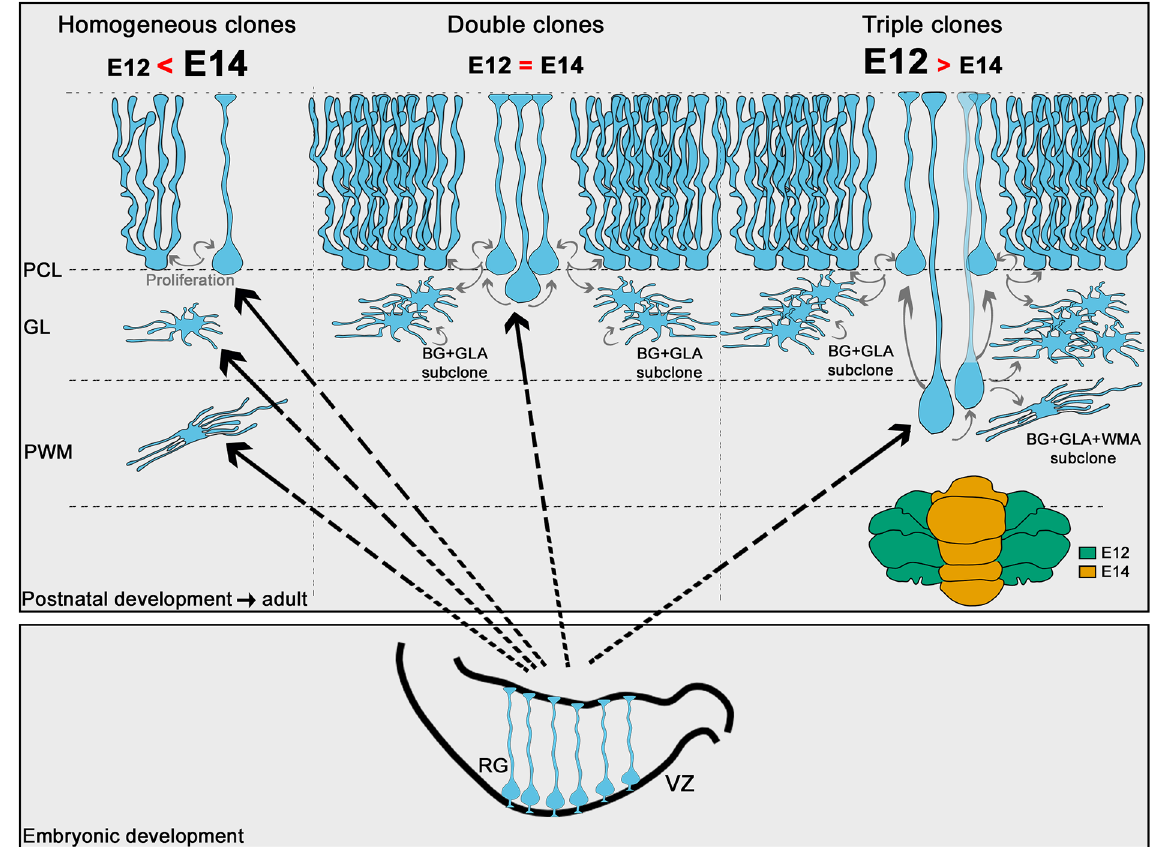
Fig 10. Schematic model for emergence of cerebellar astroglial lineages. Cerebellar astrogliogenesis occurs from RG that either generate HomCs for each major astrocyte type—more frequent among vermian E14-P30 clones—or HetCs. HetCs, including double and triple clones, are proposed to originate from intermediate basal progenitors derived from RG. Double clones are similarly produced by either E12 or E14 RG and appear composed on average of 2 subclones with the same modularity. In these subclones, BG dominates over GLAs, likely as the result of the amplification of ventricular progenitors translocated into the PCL. Triple clones, more frequent among E12-P30 lineages, include the 3 major astrocyte types and appear composed by 3 subclones belonging to distinct typologies, depending on the presence of WMAs. Subclones can be formed by BG+GLA types, in which case they show modularity, and by BG+GLA+WMA types, in which case there is no apparent modularity but a very diverse cell type composition. BG, Bergmann glia; E, embryonic day; GL, granular layer; GLA, granular layer astrocyte; HetC, heterogeneous clone; HomC, homogeneous clone; RG, radial glia; PCL, Purkinje cell layer; PWM, prospective white matter; VZ, ventricular zone; WMA, white matter